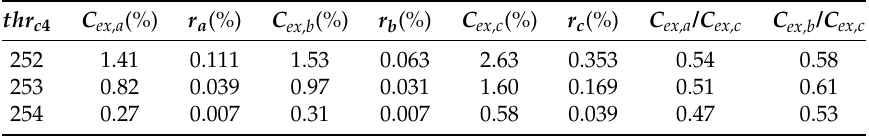
Figure 9. Box plots of length L (top left), width W (top right), length-to-width ratio R (bottom left) and area A (bottom right) for manual (in blue) and automatic (in red) masks, calculated for images a , b and c . Table 2. Expression of CX43, C ex , as a percentage of tissue area for images a , b and c , and corresponding values for the noise level r . Ratios of C ex in images a and b with respect to image c are presented in the last two